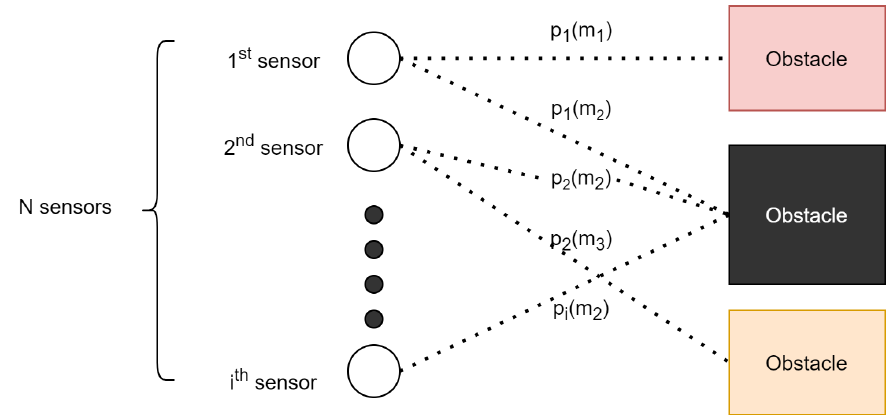
Figure 3. Multiple sensors